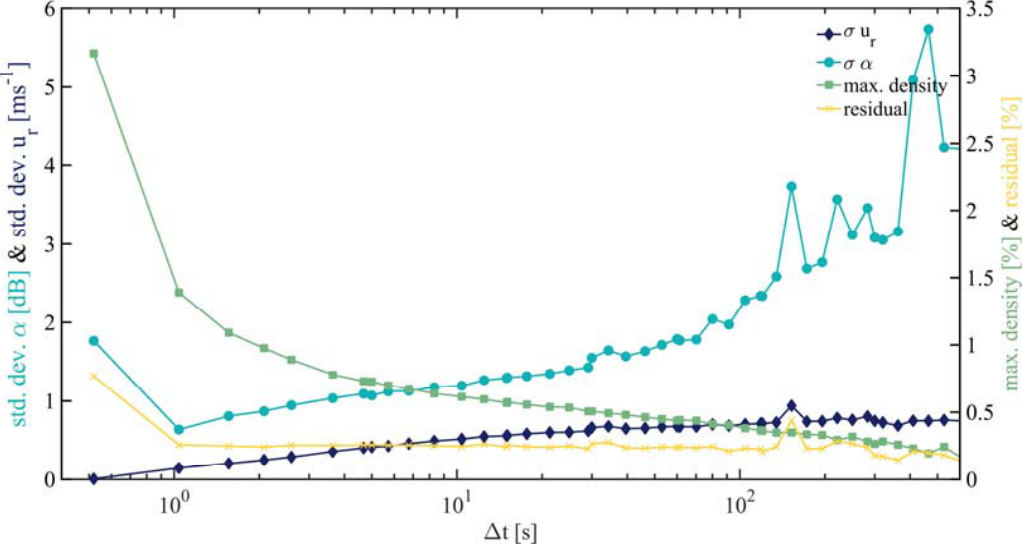
Figure 5. Behaviour of parametrisation of fitted bi-variate Gaussian distribution of data density in relation to the different normalisation time intervals ∆ t . The α -axis fitted standard deviation is shown in turquoise, u r -axis fitted standard deviation in dark blue, the maximum probability of occurrence in green and the residual of the original and the fitted data distribution.